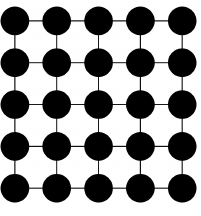
Figure 1 – Perfect crystal with minimum